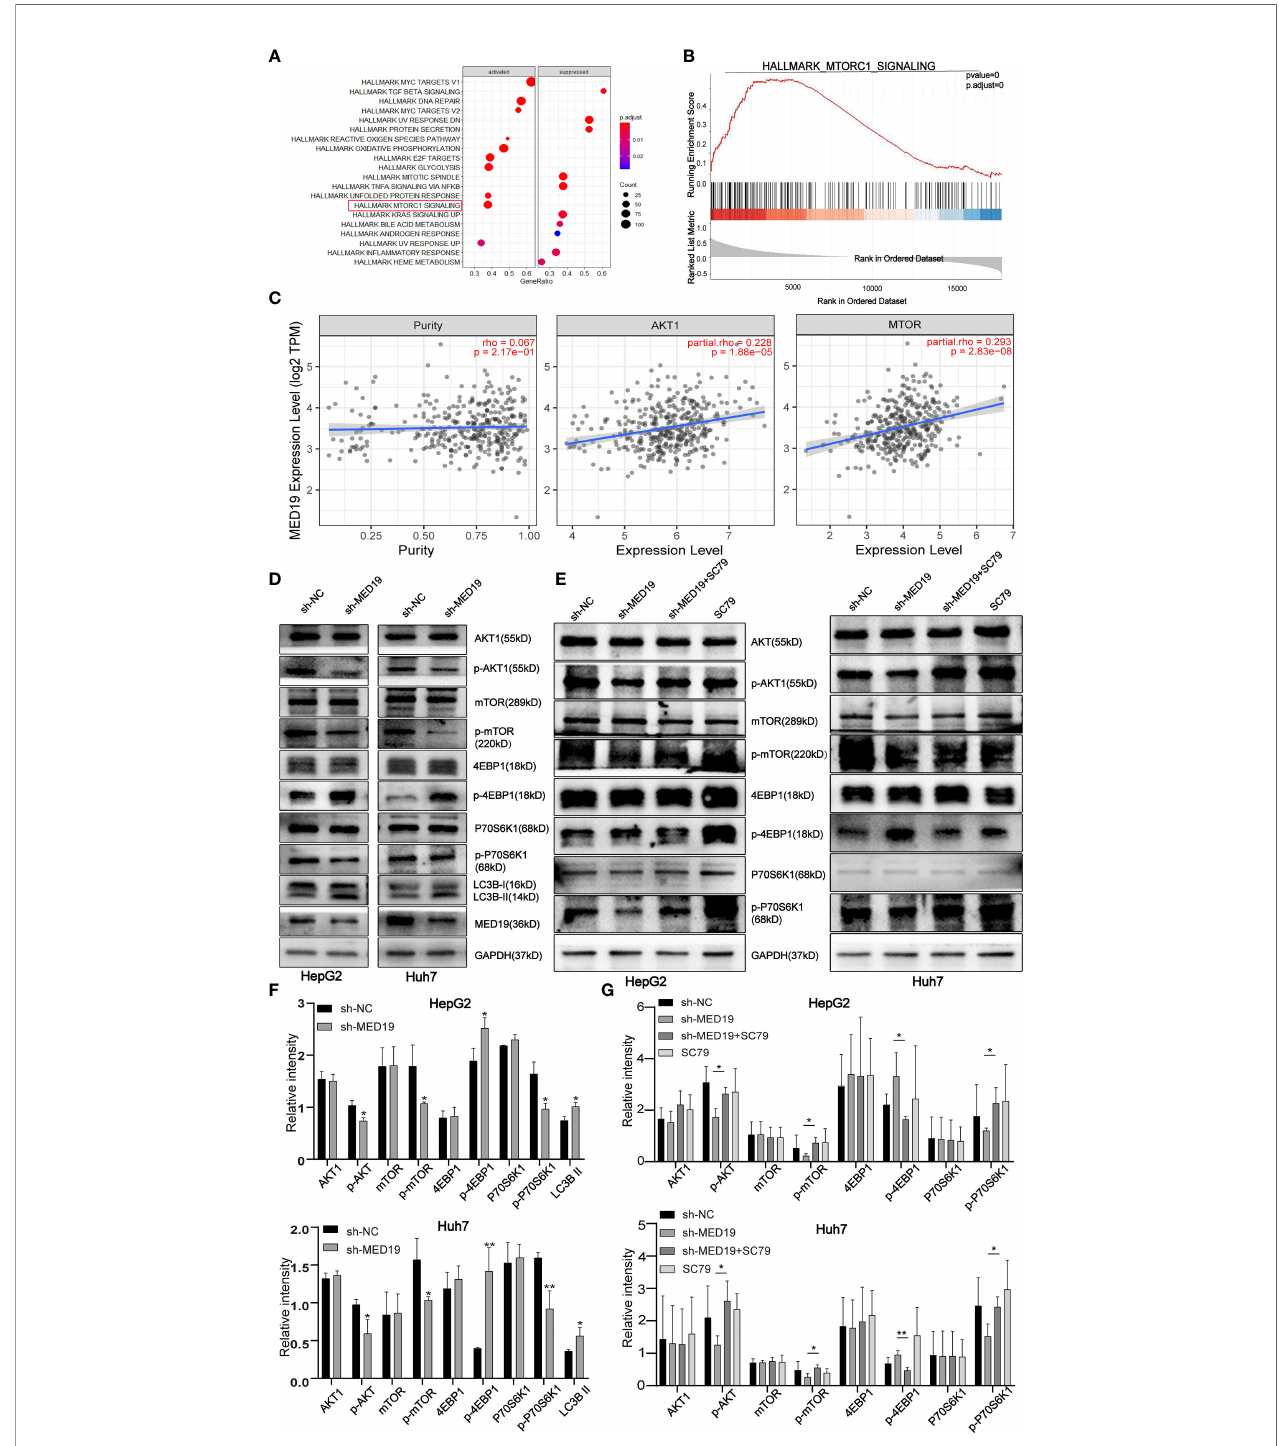
FIGURE 5 | MED19 knockdown inhibited AKT/mTOR signaling pathway. (A, B) Pathway enrichment analysis of MED19 in HCC. (C) Co-expression analysis of MED19 and AKT/mTOR pathway genes. (D, F) The protein expression of AKT , p-AKT , mTOR , p-mTOR , p70S6K1, p-p70S6K1, 4EBP1, p-4EBP1 , and LC3B I/II in HepG2 and Huh7 cells from the sh- MED19 and sh-NC groups. (E, G) SC79 enhances the expression of p-AKT, p-mTOR , and p-p70S6K1 but inhibits the expression of p-4EBP1 . * P < 0.05; ** P < 0.01. Perform three independent replicates. Statistical analysis is performed using an unpaired t - test. All results are expressed as mean ±